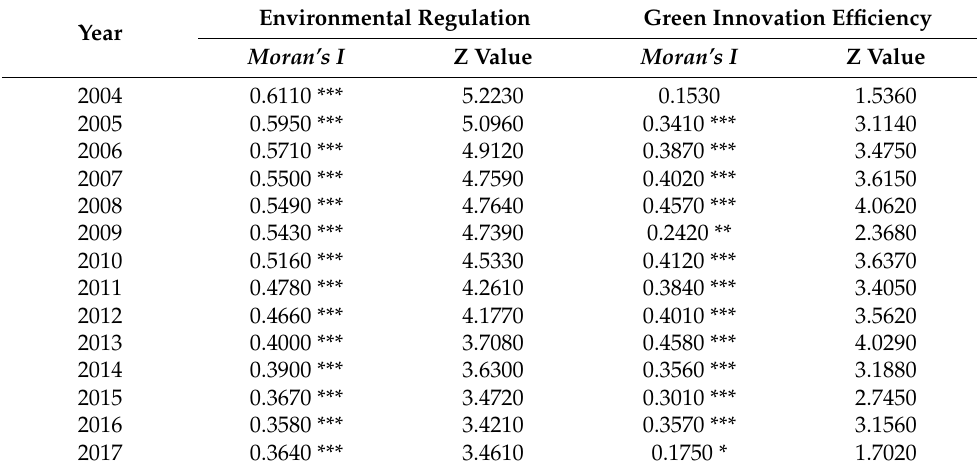
Table 3. The test results of Moran’s I